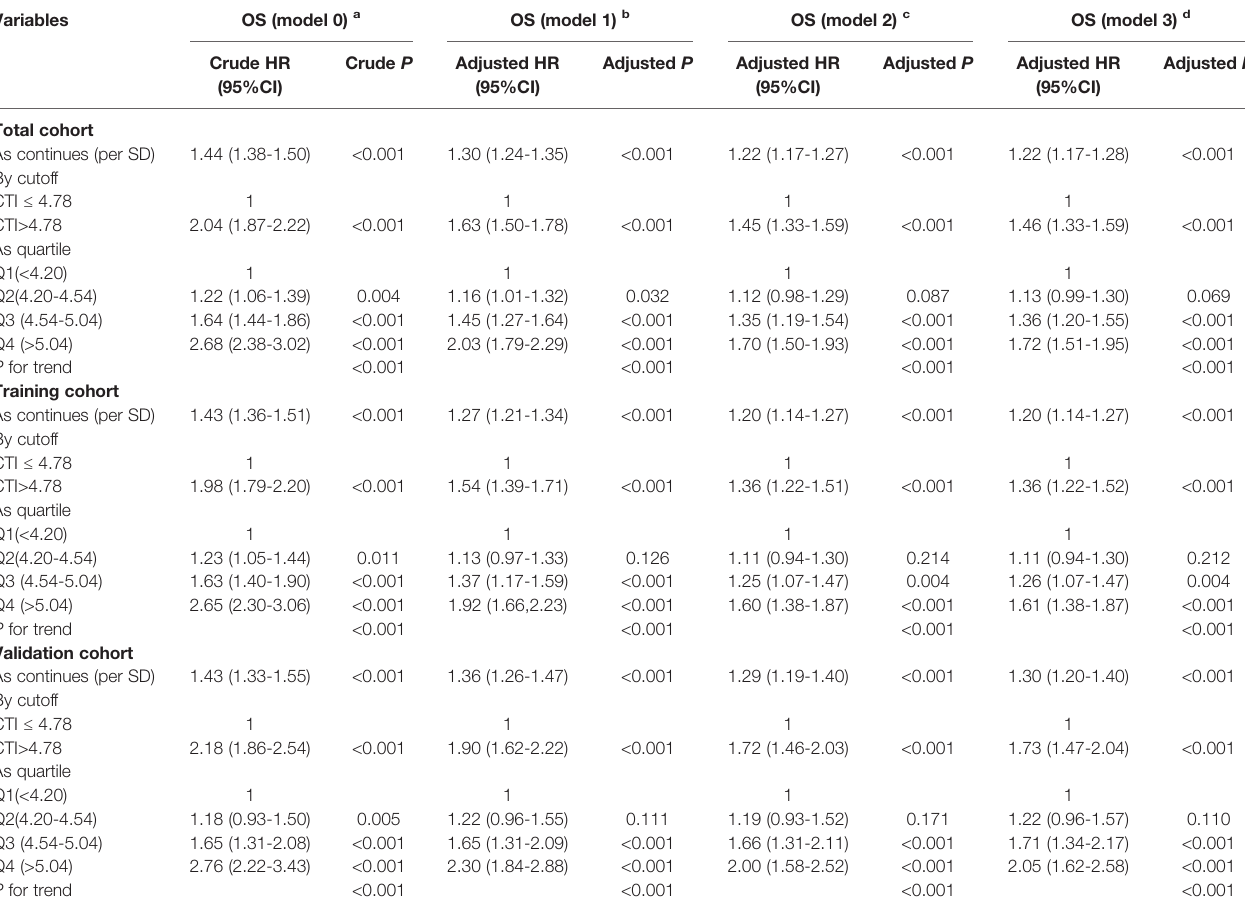
TABLE 3 | Univariate and multivariate analysis of CTI in total, training, and validation cohort.